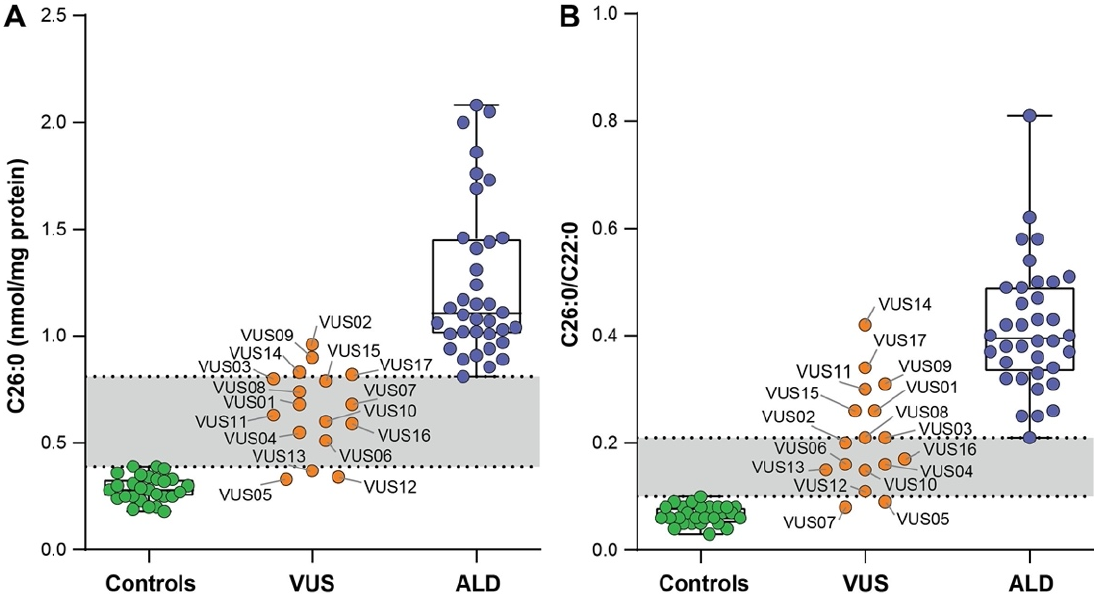
Figure 1. C26:0 levels ( A ) and C26:0/C22:0 ratios ( B ) analyzed using gas chromatography. Scatter dot plots show values for the fibroblasts of the control subjects (green circles); fibroblasts of the individuals with a VUS in ABCD1 (orange circles); and fibroblasts of the ALD patients (blue circles). The VUS fibroblasts are labelled by ID. Both C26:0 levels and C26:0/C22:0 ratios were elevated in the ALD fibroblasts compared to control cells.